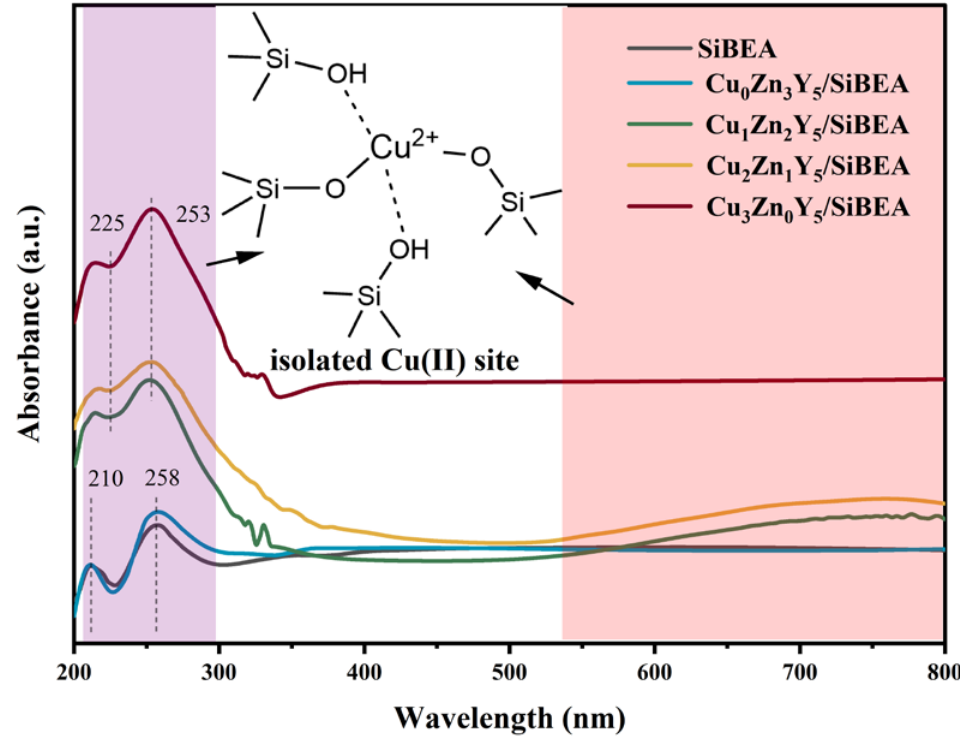
Figure 3. The DR UV-Vis spectra of SiBEA and CuZnY/SiBEA catalysts.